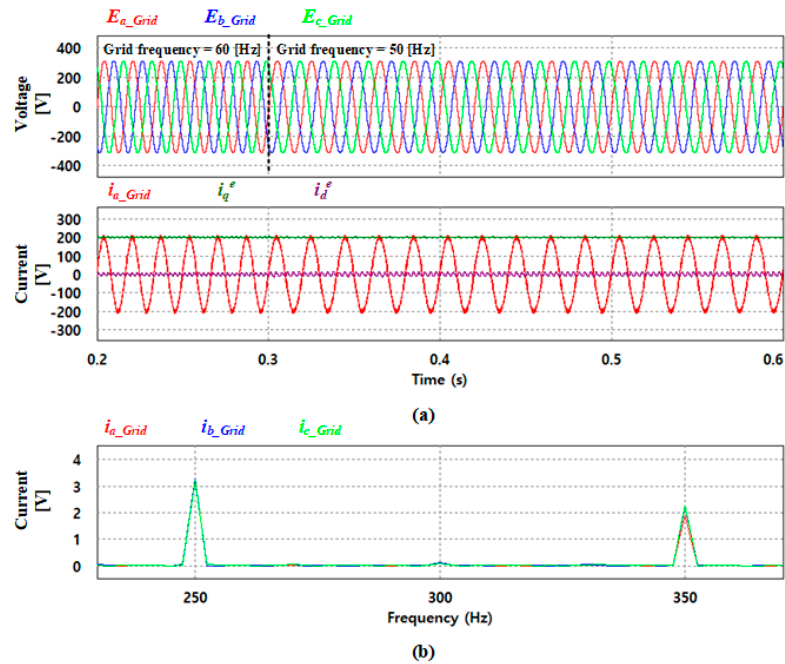
Figure 18. Conventional harmonic compensation method (grid frequency: 60 Hz → 50 Hz): ( a ) three-phase grid voltage, a-phase current, and d-q axis current; ( b ) FFT analysis result of three-phase current.